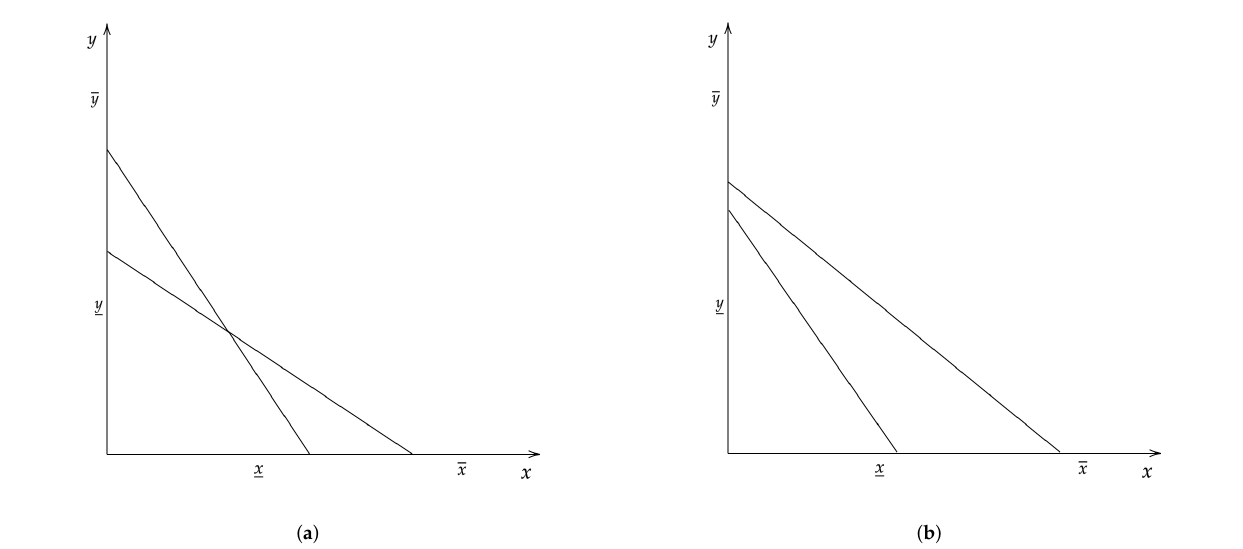
Figure 1. Example Budget Sets. ( a ) Set 1, ( b ) Set